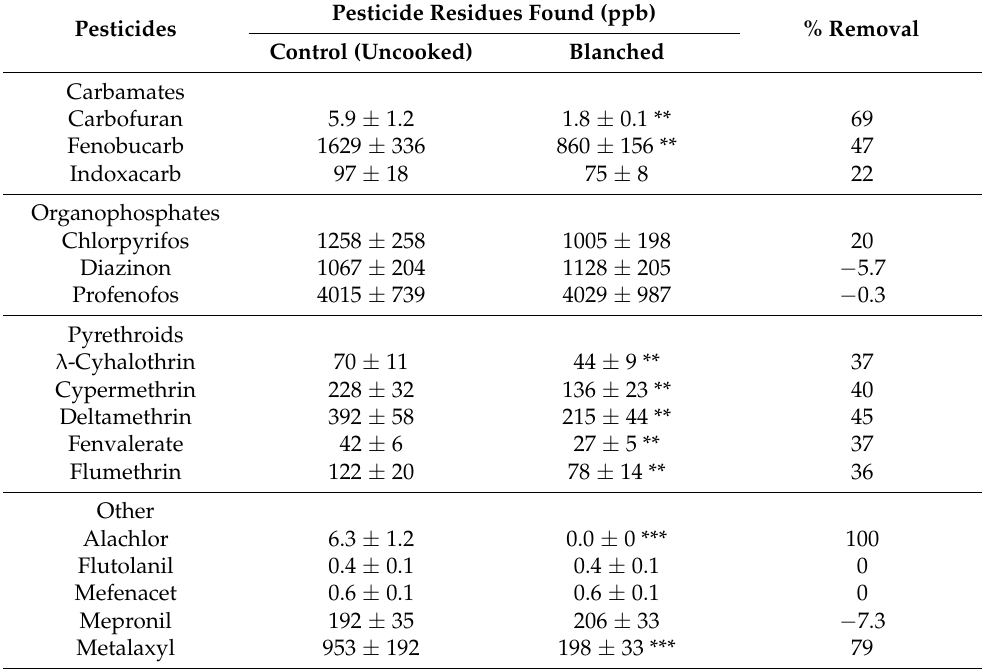
Table 2. Effects of blanching on the removal of pesticide residues from the Chinese kale